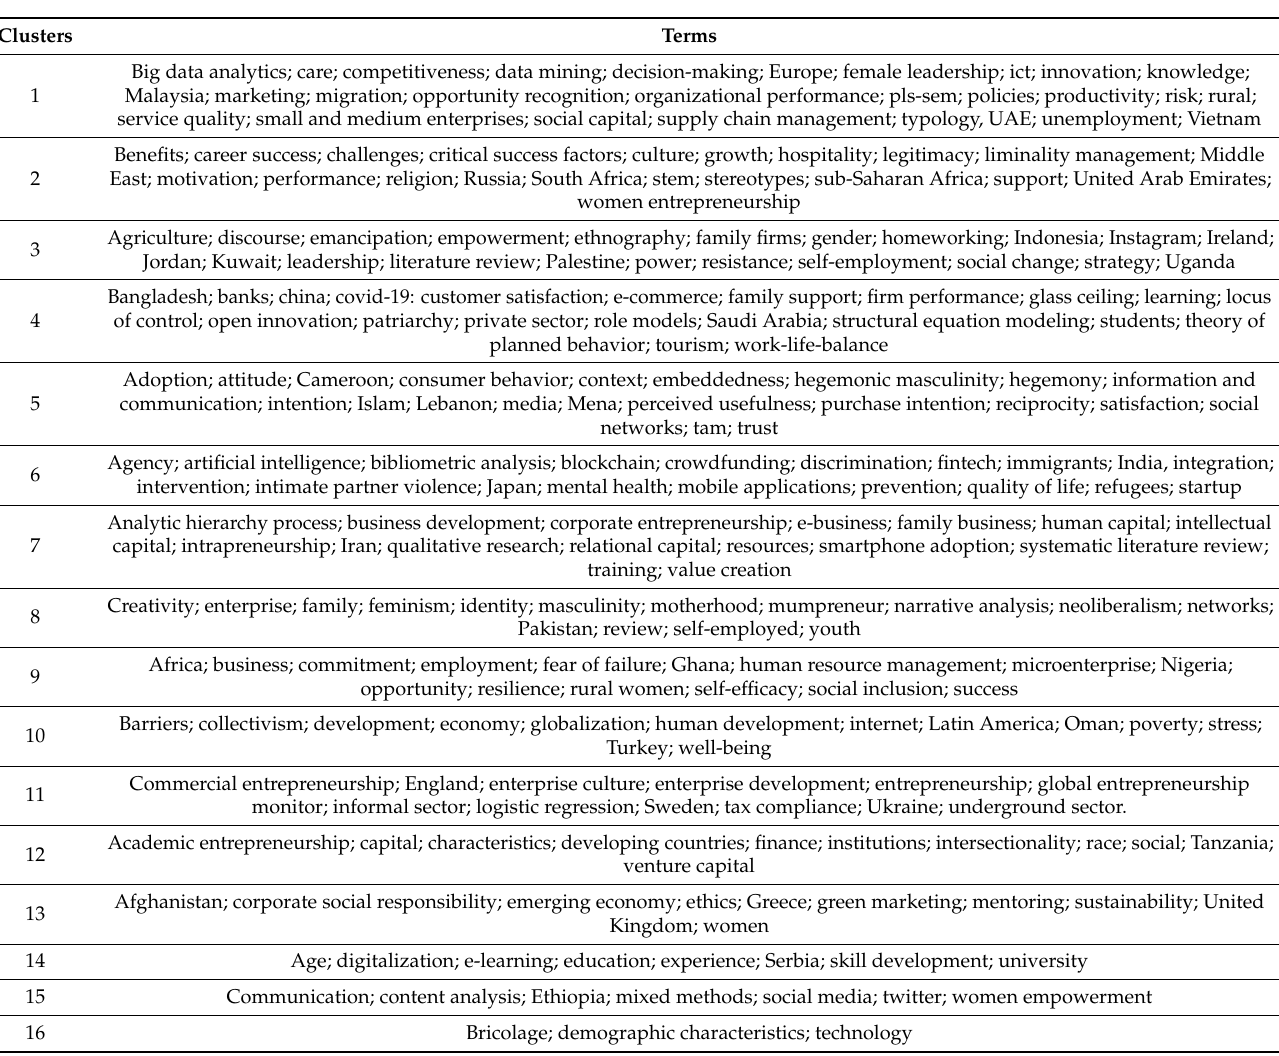
Table A1. Co-occurrence clusters of author’s keywords